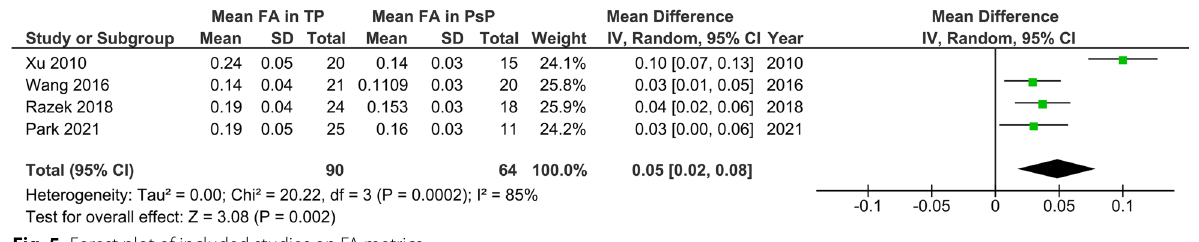
Fig. 5 Forest plot of included studies on FA